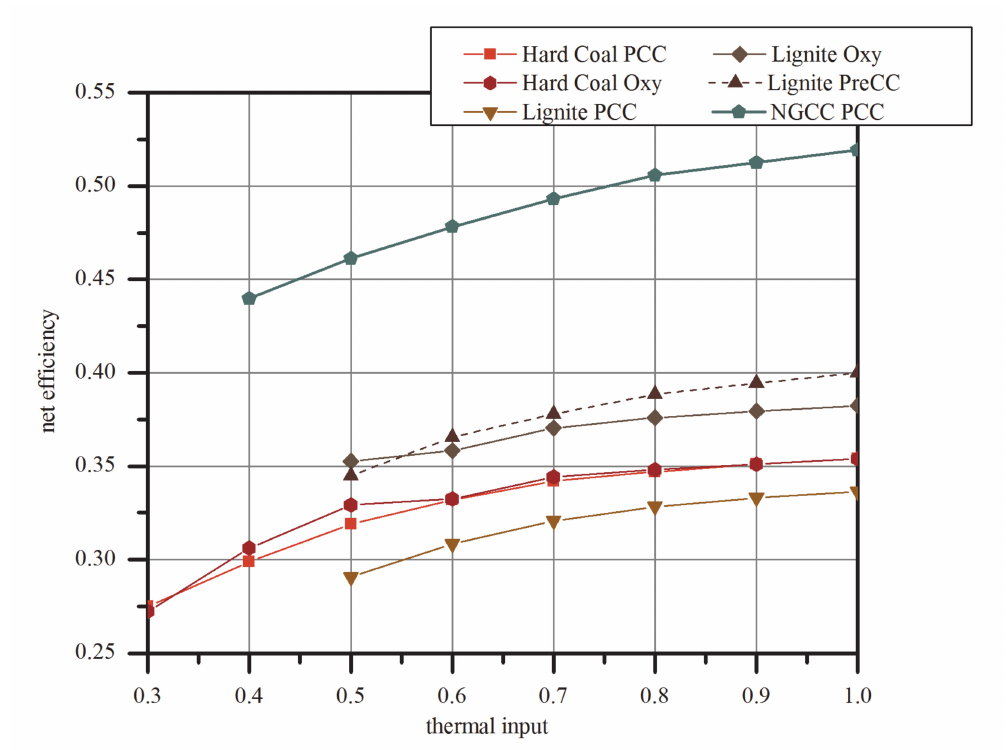
Figure 2. Net e ffi ciency over the rated thermal input of the considered power plants equipped with CO 2